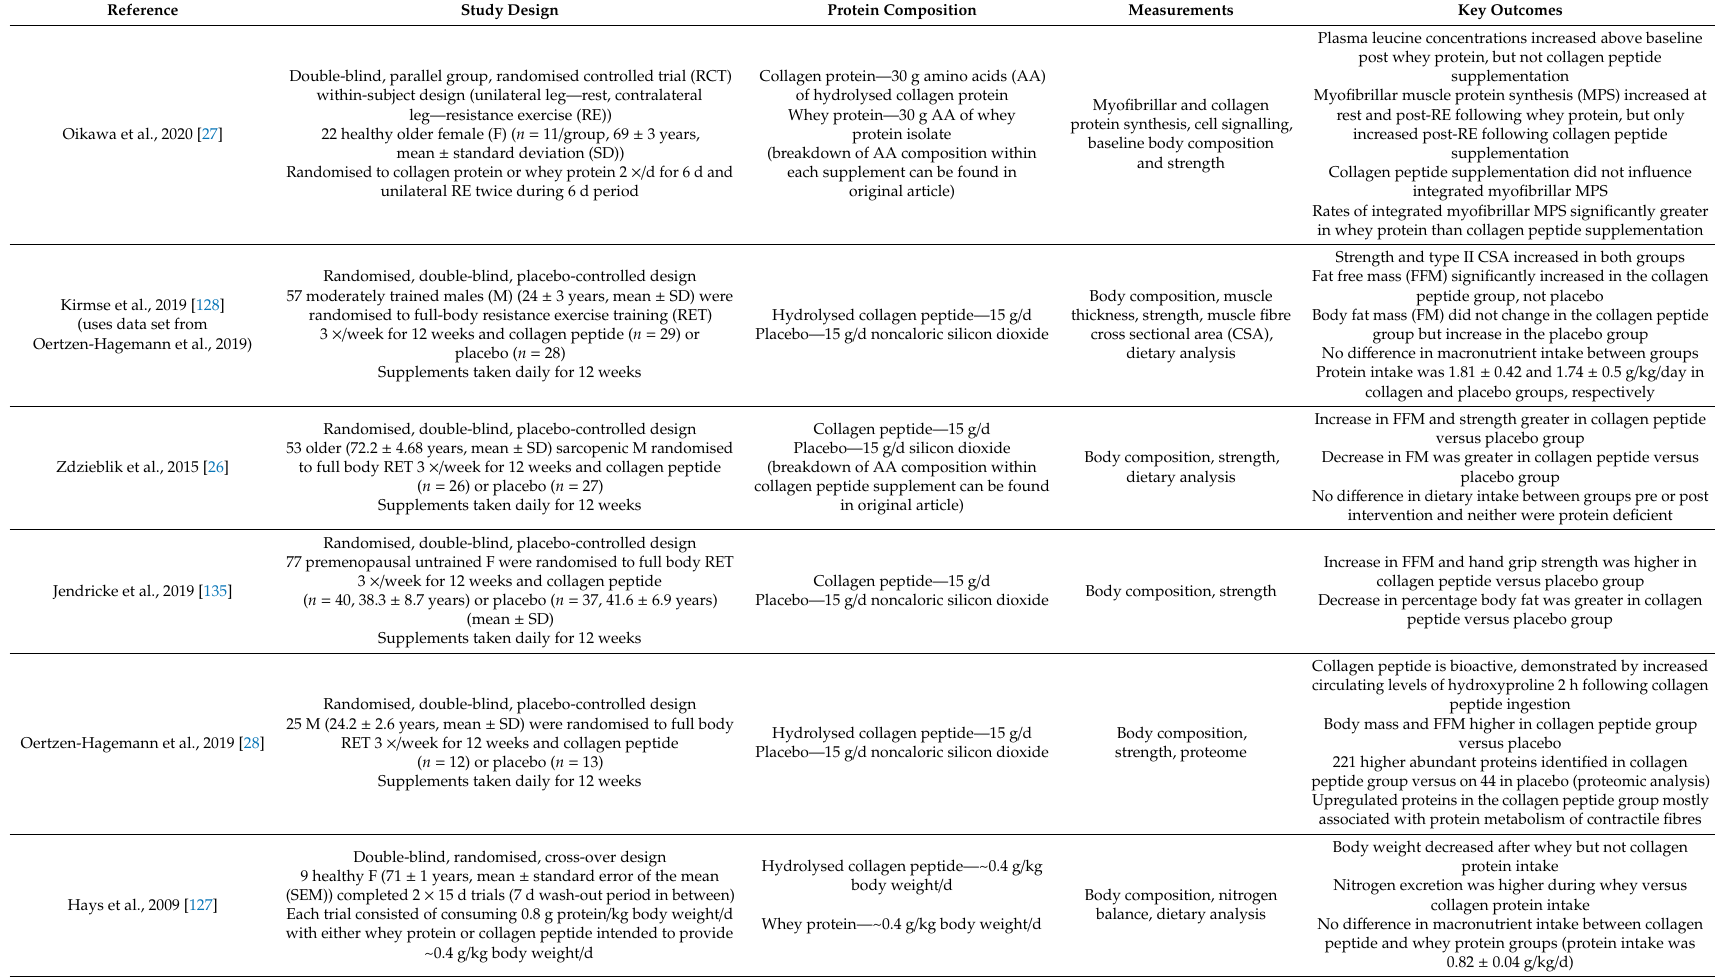
Table 5. Collagen-derived proteins: e ff ects on muscle in relation to age, exercise, energy restriction and